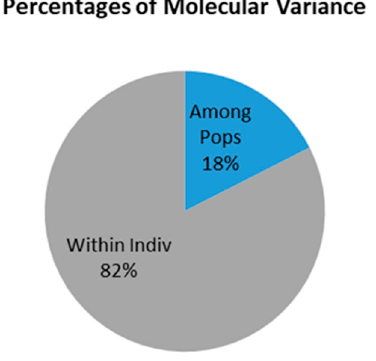
Figure 1. Percentages of AMOVA based on 14 STR markers.